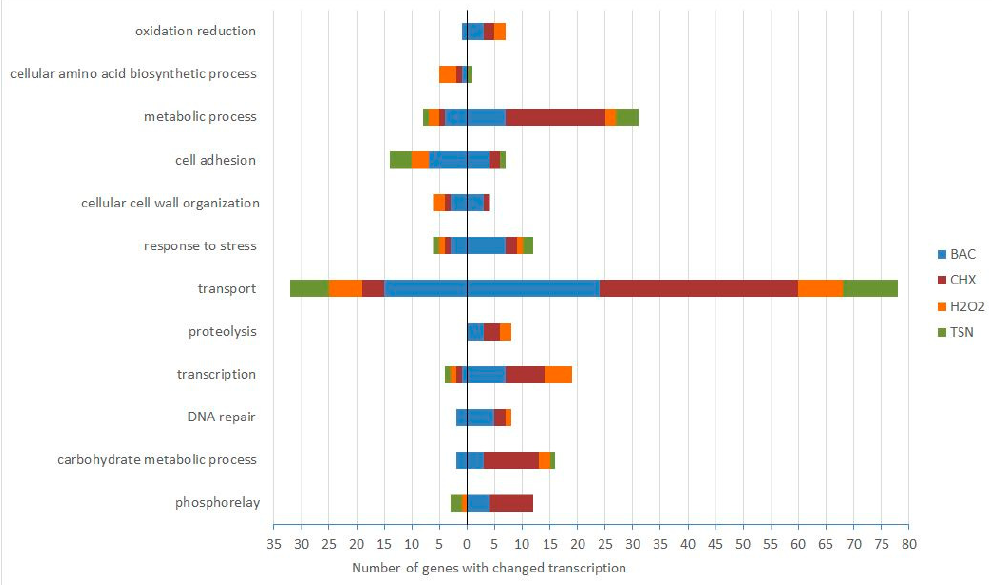
Figure 1. Number of genes with changed transcription following biocide treatment, grouped according to the gene ontology (GO) term biological process. The number of genes with reduced transcript levels: left side of the y-axis, with elevated transcript levels: right side of the y -axis. BAC—benzalkonium chloride, CHX—chlorhexidine, H 2 O 2 —hydrogen peroxide, TSN—triclosan. Only GO groups where transcription of more than 20 genes was elevated or reduced for all the four biocides are